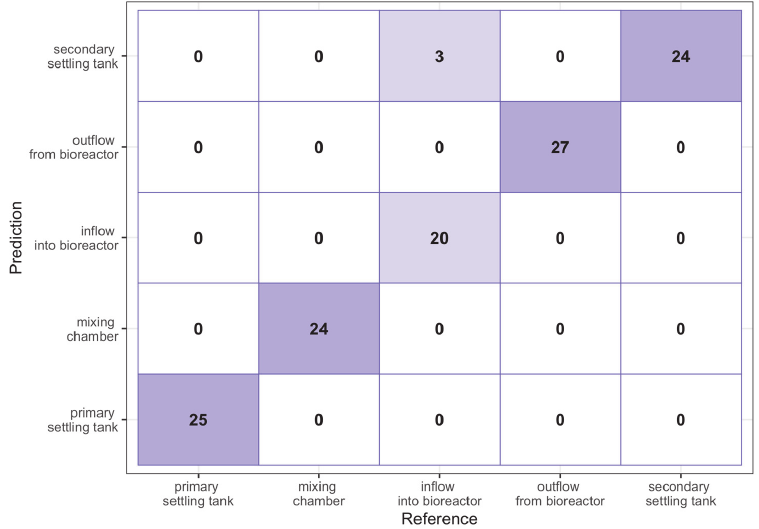
Figure 5. Contingency matrix for random forest model on the learning sample.